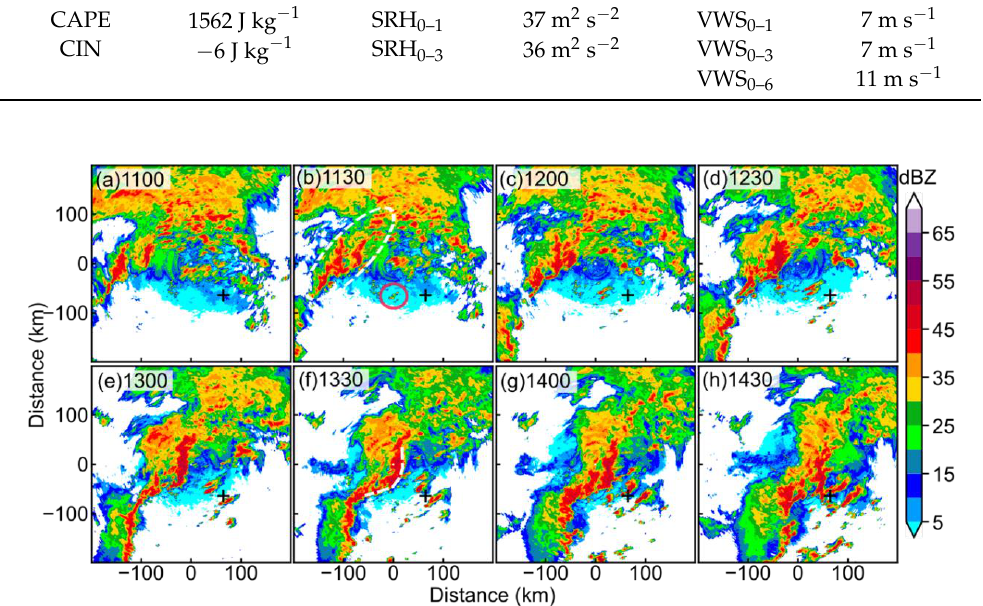
Figure 3. Composite reflectivity fields of the meso- squall line showing its different stages ( a – h ) from 1100 to 1430 LTC. The red circle in ( b ) marks the location of the supercell. The white dashed line in ( b ) marks the squall line in its early stage. The white dashed line in ( f ) marks the bow echo of the squall line. The black cross represents the tornado location. Although the meso- squall line was the predominant feature on the radar echoes, the distance between the squall line and the tornado was greater than 30 km at the closest time (Figure 3g). Therefore, the squall line unlikely contributed to the genesis of this tor- nado directly. It is noted that an isolated convective cell (the red circle in Figure 3b) with a diameter of about 10 km was initialized about 100 km in front of the developing squall line and was responsible for the formation of this tornado. Figure 4 shows the evolution of radar reflectivity of the supercell from 1300 to 1400 LTC using the HA, NJ, and TZ radars. The reflectivity fields of the three radars were consistent and indicated that the supercell intensified slowly before 1330 LTC. The supercell developed a hook echo (the red dashed circles in Figure 4(d1 – d3)) and intensified rapidly after 1330 LTC. The maxi-